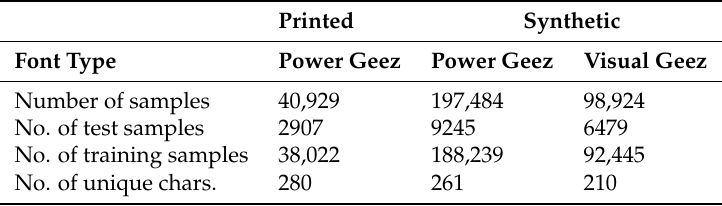
Table 1. The details of the text-line images in the dataset